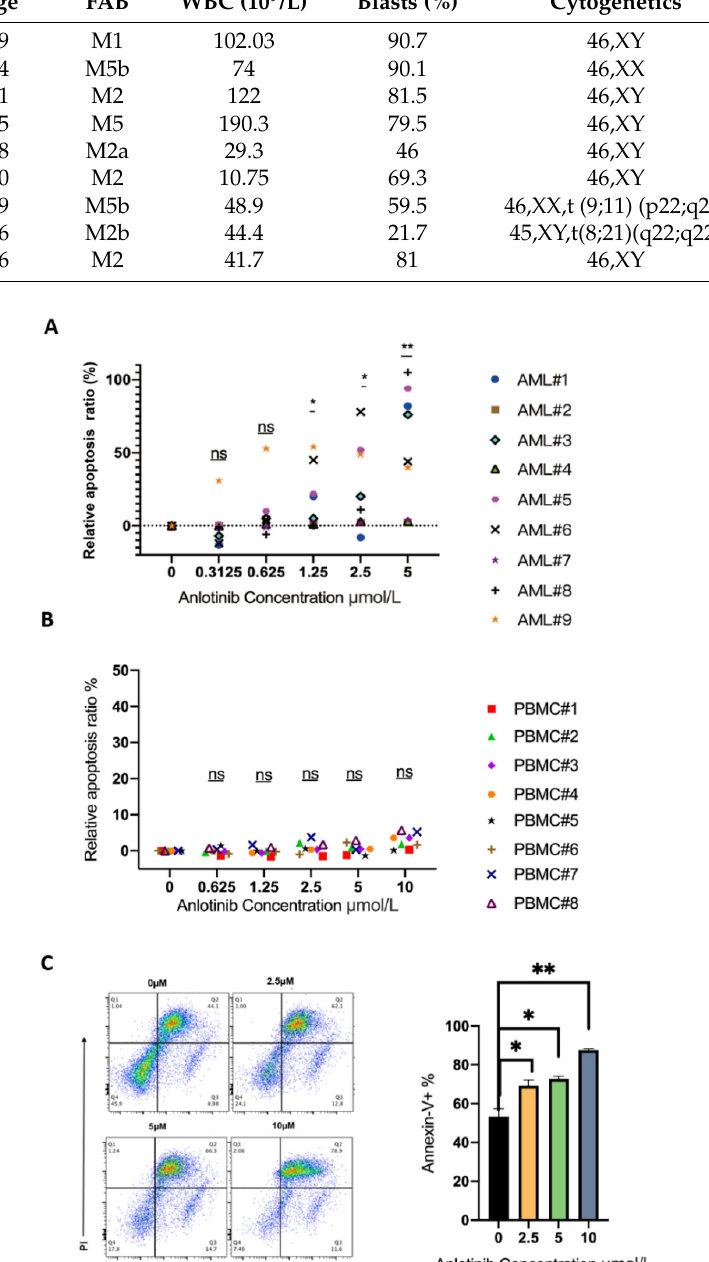
Figure 2. The cytotoxicity of anlotinib on primary CD34 + AML cells, normal leukocytes, and CD34 + CD38 − LSCs ex vivo. ( A ) The relative apoptosis of CD34 + AML cells after anlotinib treatment with indicated concentration ( n = 9). ( B ) The apoptosis of mononuclear cells from the peripheral blood of healthy donors ( n = 8). ( C ) The apoptosis of CD34 + CD38 − LSCs from AML patients ( n = 3) * p < 0.05, ** p <